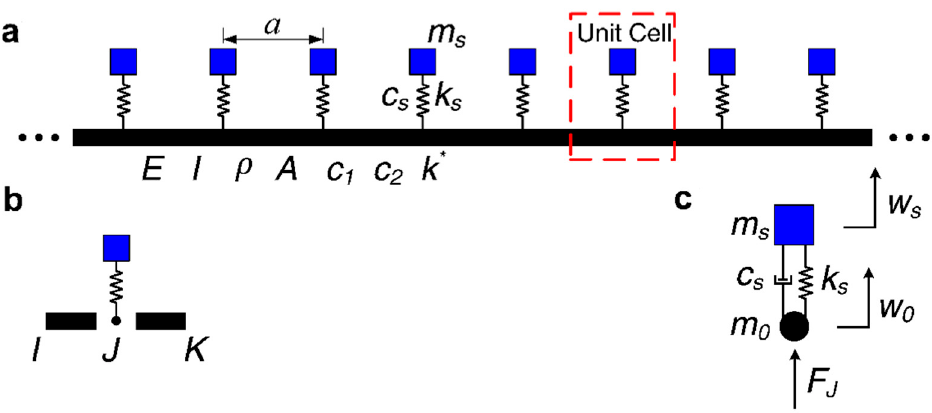
Figure 1. The physics model: ( a ) Schematic diagram of infinite long periodic oscillator coupled damping beam; ( b ) schematic diagram of the unit cell; ( c ) coupling system of spring-mass oscillator and the beam node in a unit